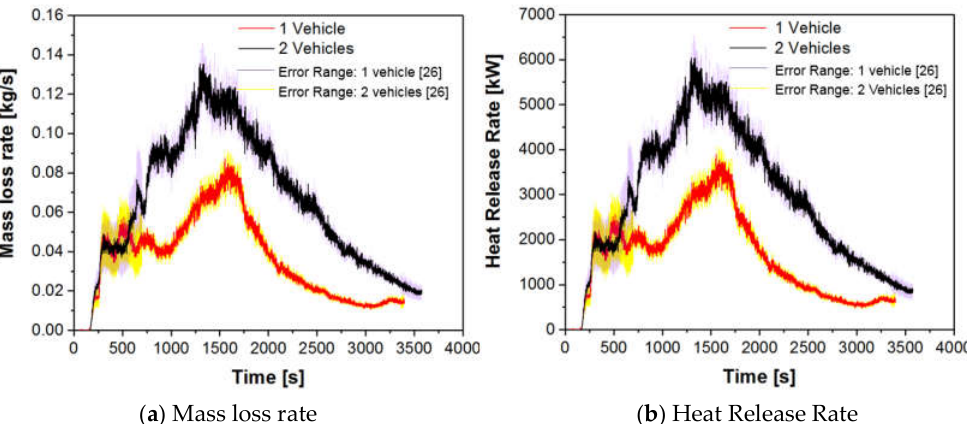
Figure 13. Mass loss rate and heat release rate for one and two vehicles as a function of time, error range estimated following Melcher et al. [26]: ( a ) Mass loss rate and ( b ) heat release rate.